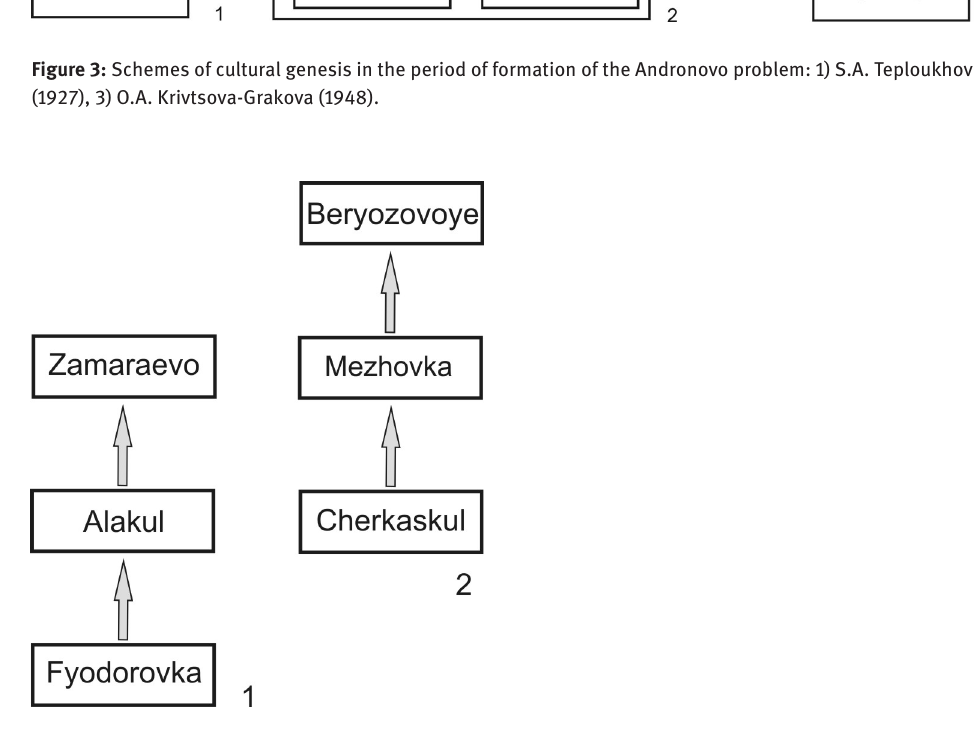
Figure 4: Scheme of Andronovo cultural genesis of K.V. Salnikov (1948, 1951) for steppe and forest-steppe (1) and for forest (2)